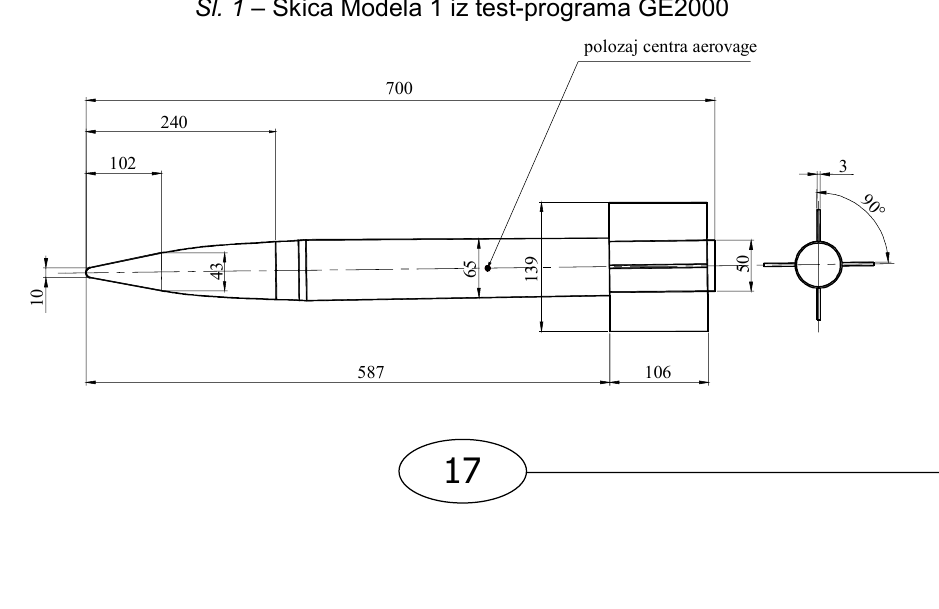
Eksperiment Opis modela i